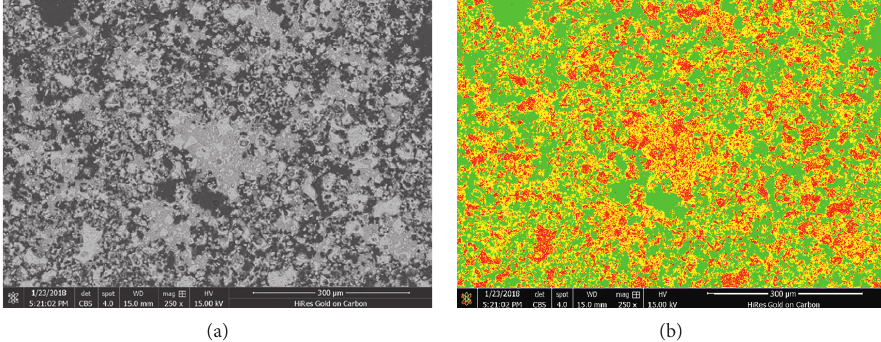
Figure 13: Color rendering of the EBSD picture based on the gray value.